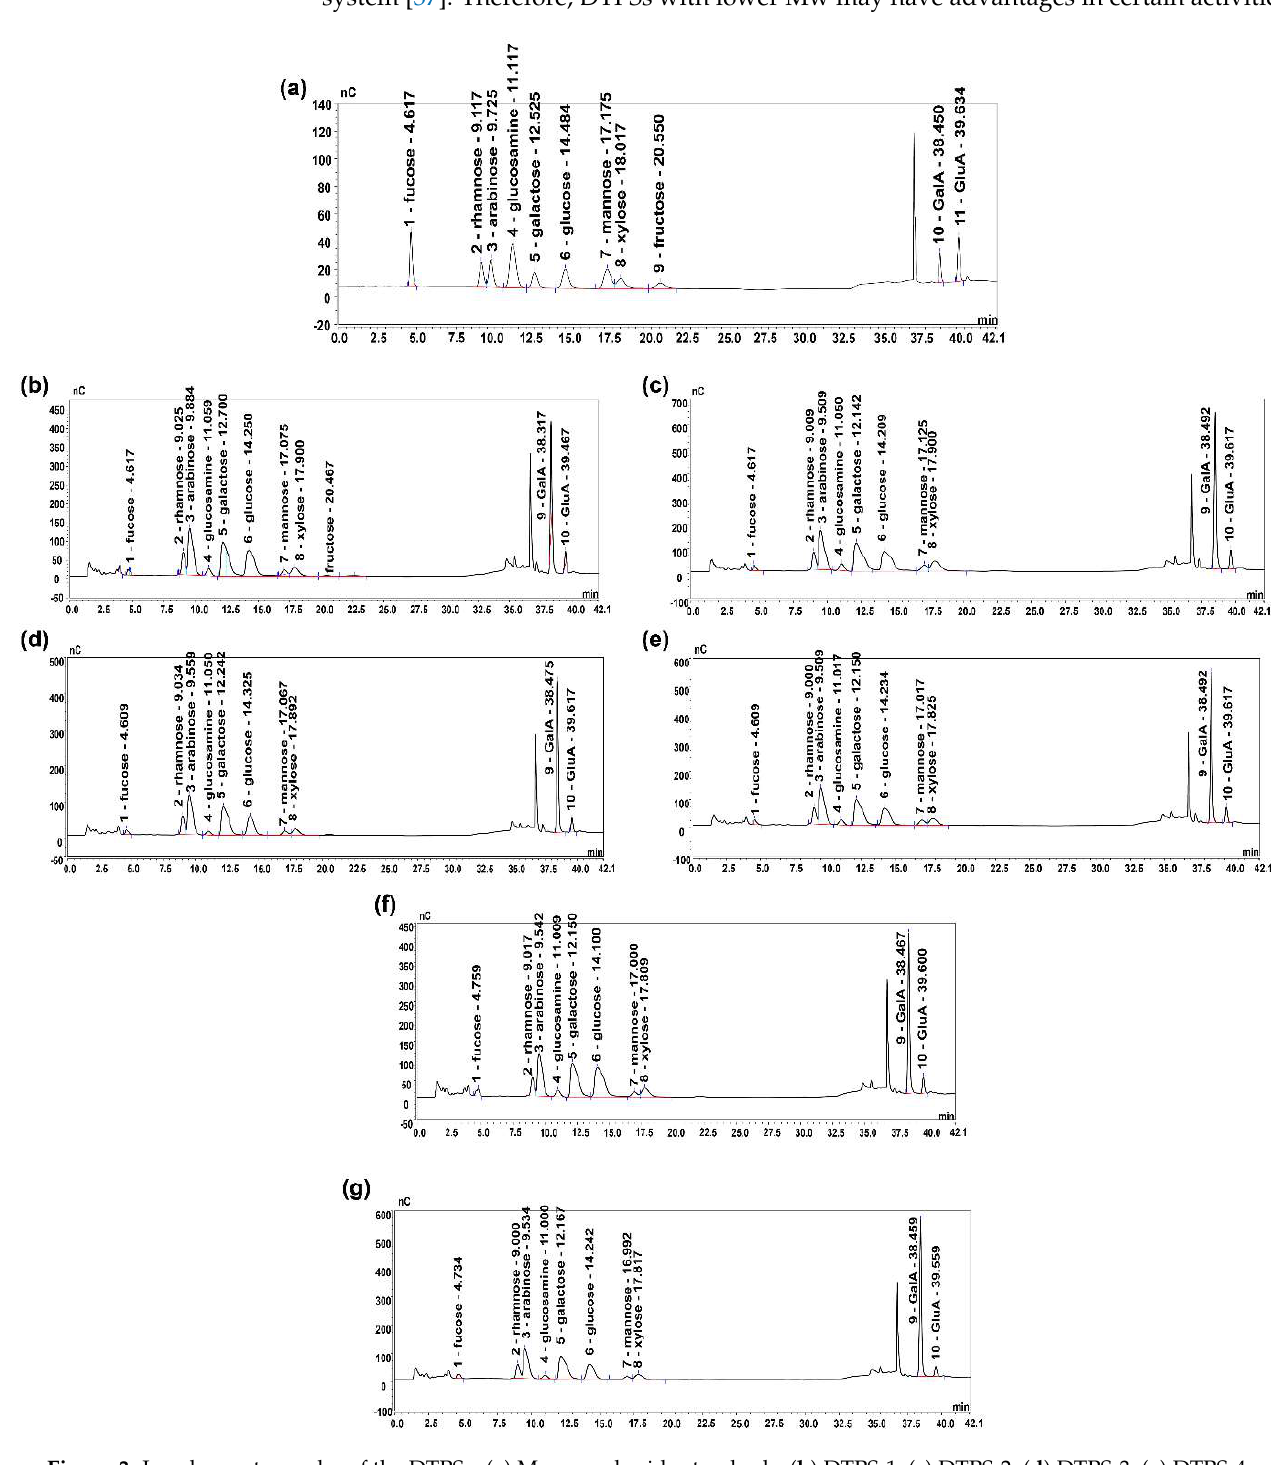
Figure 3. Ion chromatography of the DTPSs. ( a ) Monosaccharide standards, ( b ) DTPS-1, ( c ) DTPS-2, ( d ) DTPS-3, ( e ) DTPS-4, ( f ) DTPS-5, and ( g ) DTPS-6.